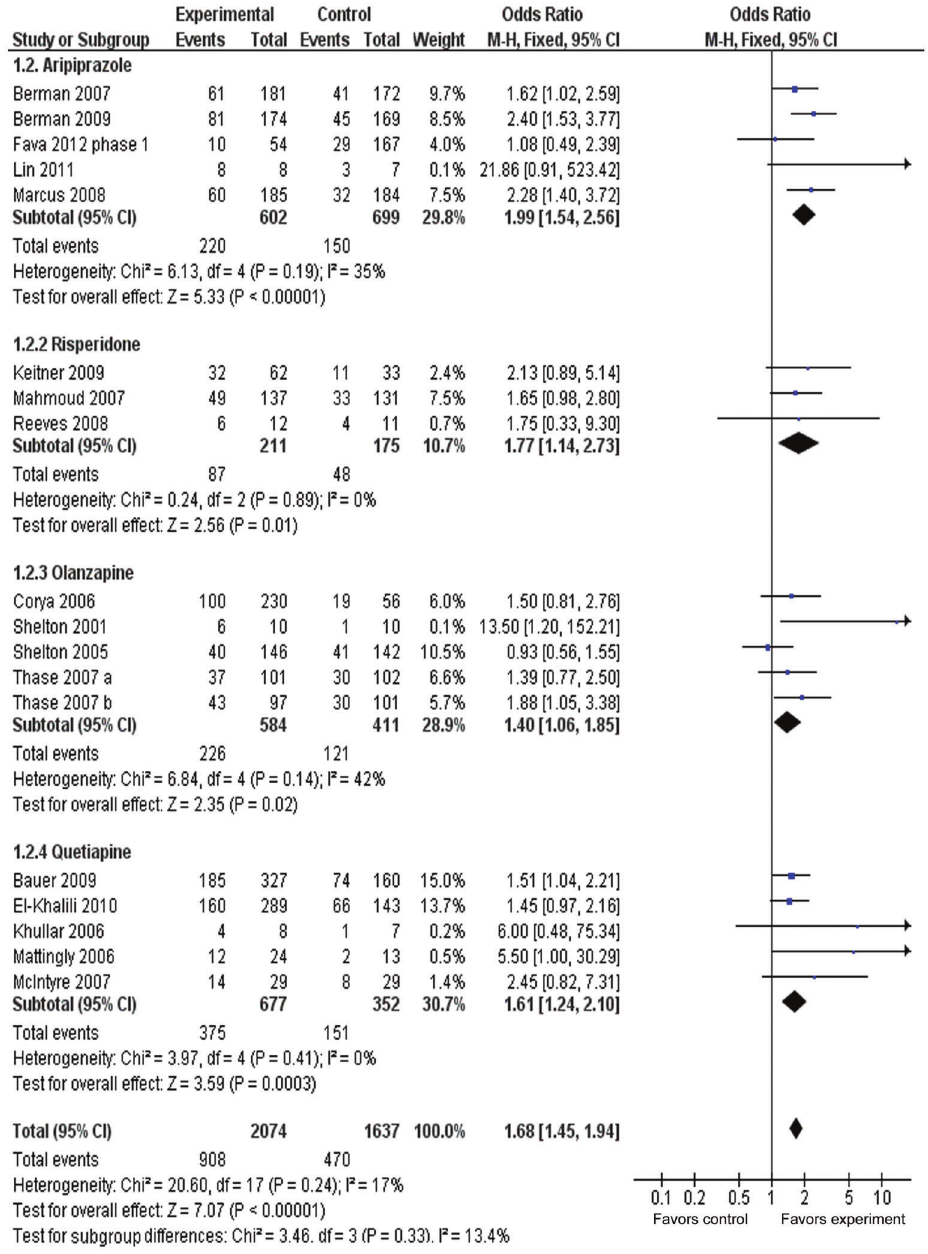
Figure 4. Meta-analysis of response rates of adjunctive atypical antipsychotics in major depressive disorder. Odds ratios for response to drug and placebo are grouped by types of atypical antipsychotics. Thase et al. (29) contains two identical trials. All trials were included in this subgroup